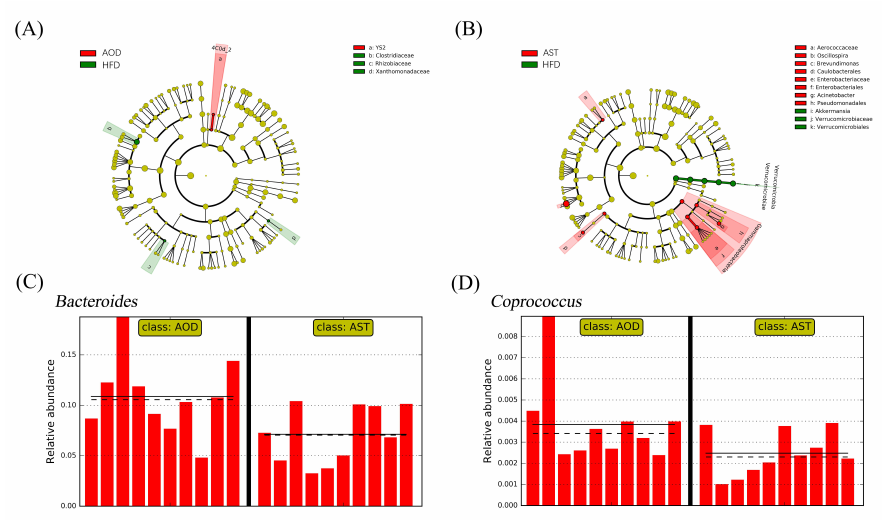
Figure 6. Select taxa with significant di ff erence in abundance of AOD, AST, and HFD samples using linear discriminant analysis (LDA) e ff ect size (LEfSe) analysis. Taxa meeting a significant LDA threshold value of > 2.0 and its corresponding taxonomic cladogram are depicted in ( A ) AOD vs. HFD groups (red: AOD-enriched taxa; green: HFD-enriched taxa) and ( B ) AST vs. HFD groups (red: AST-enriched taxa; green: HFD-enriched taxa). ( C ) Bacteroides and ( D ) Coprococcus are selected microbial genera displaying significant di ff erences in their relative abundance in the gut microbiota between AOD and AST. x -axis: individual samples. y -axis: relative abundance. Straight line: group mean abundance. Dotted line: median. HFD: high-fat and high-sucrose diet; AOD: high-fat and high-sucrose diet supplemented with astaxanthin n -octanoic acid diester (50 mg / kg body weight) for 8 weeks; AST: high-fat and high-sucrose diet supplemented with free astaxanthin (50 mg / kg body weight) for 8 weeks.